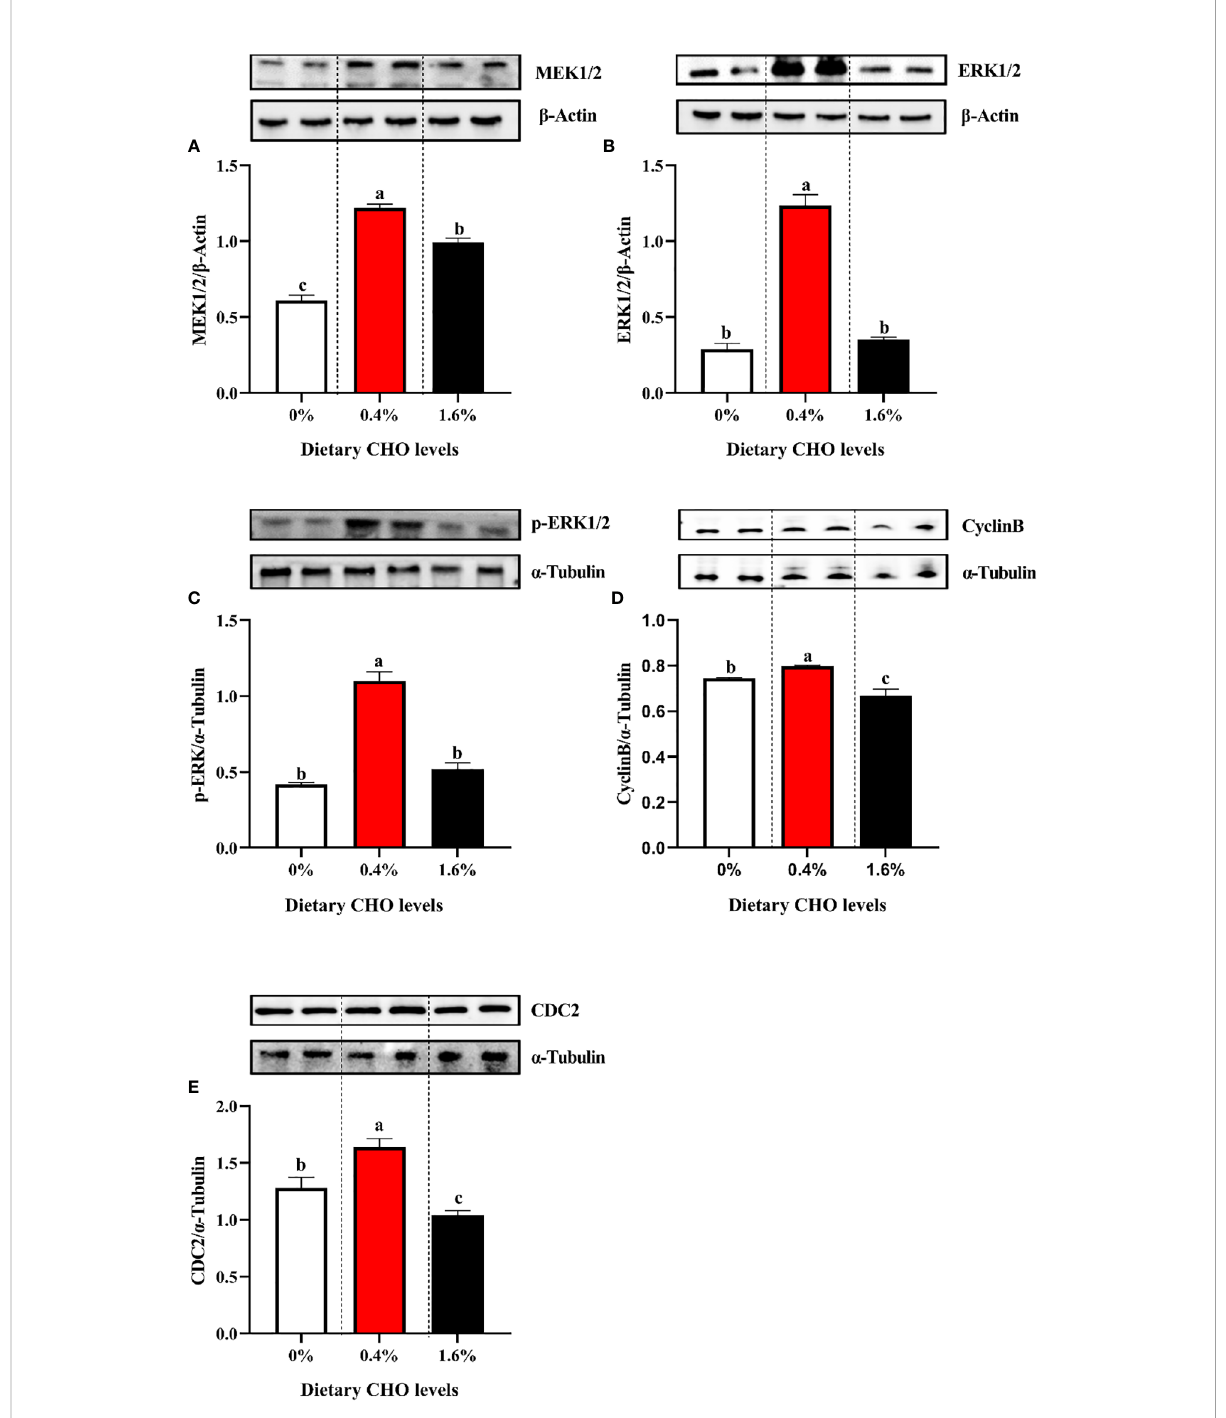
FIGURE 4 Western blot analysis of (A) the protein expression of MEK1/2 in ovary; (B) the protein expression of ERK1/2 in ovary; (C) the protein expression of p-ERK1/2 in ovary; (D) the protein expression of Cyclin B in ovary; (E) the protein expression of CDC2 in ovary. The values are the Means ± SEM (n = 4). Different letters indicate signi fi cant differences ( P <